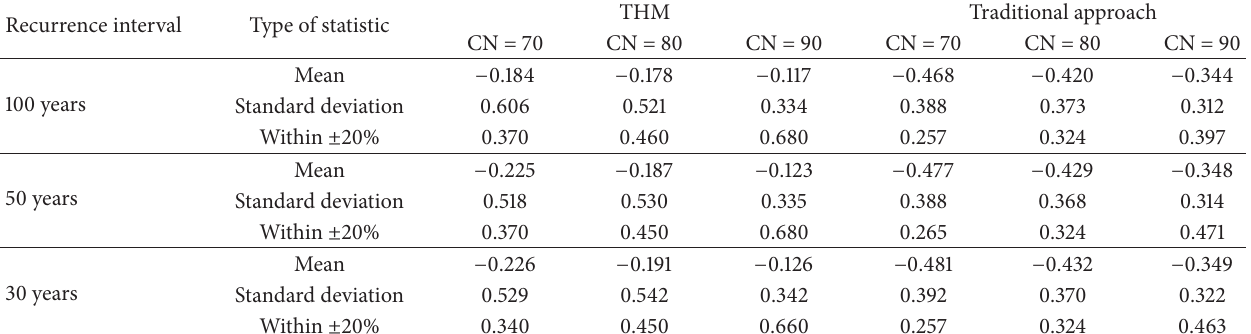
Table 2: Performance comparison between THM and the traditional approach in reproducing design flow values.